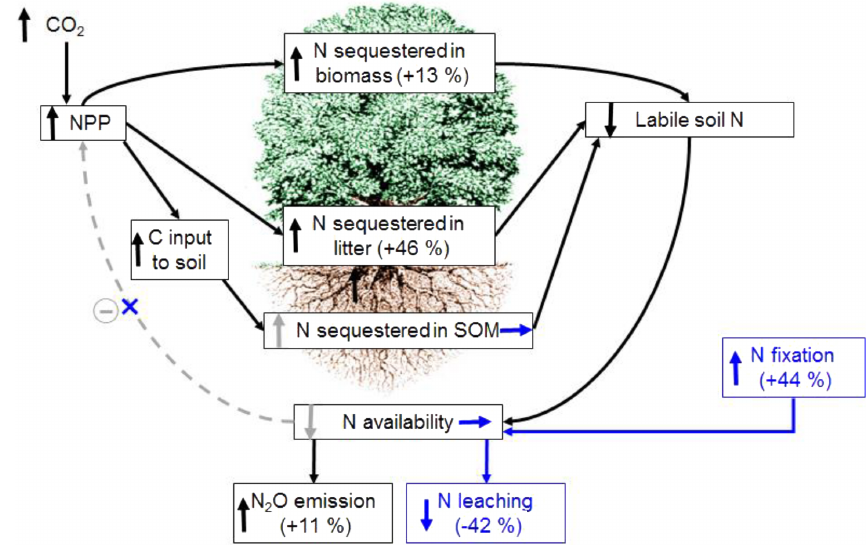
Figure 5. Mechanisms that alleviate PNL. PNL hypothesis posits that the stimulated plant growth by CO 2 enrichment leads to more N sequestered in long-lived plant tissues, litter and soil organic matter (SOM) so that, the N availability for plant growth progressively declines over time, and plant growth is downregulated (grey symbols). The current synthesis indicates that the basis of PNL occurrence partially exists (i.e., more N sequestered in plant tissues and litter; black symbols). Despite of the increases in plant N sequestration and N 2 O emission, stimulated biological N fixation and reduced N leaching can replenish the N availability, potentially alleviating PNL (blue boxes and arrows). Upward, downward, and horizontal arrows mean increase, decrease, and no change,